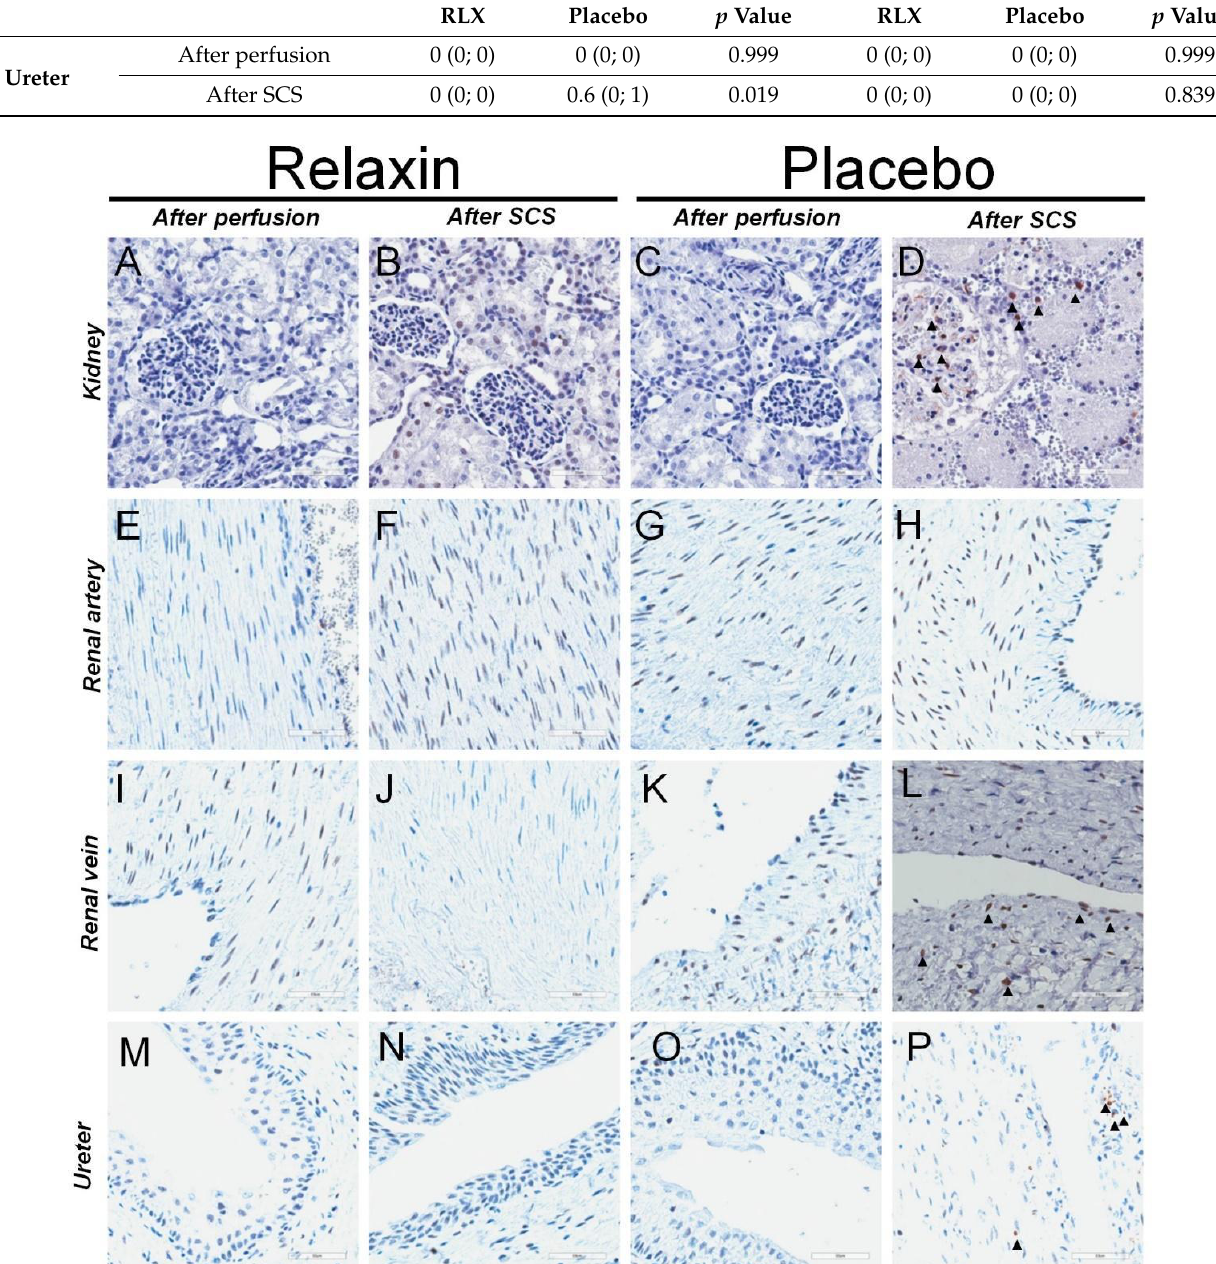
Figure 4. Pictures depicting typical staining for activated Caspase 3 in kidney, renal artery, renal vein, and ureter tissues after perfusion and static cold storage in RLX or control. Representative staining for kidney tissue at 100× magnification for Caspase 3 after perfusion ( A ) and static cold storage ( B ) with RLX and after perfusion ( C ) and static cold storage ( D ) with Custodiol ® . Caspase 3 positive cells were more common after SCS in a Placebo group. Representative staining for renal artery tissue against Caspase 3 after perfusion ( E ) and static cold storage ( F ) with Custodiol ® supplemented with Relaxin or after perfusion ( G ) and static cold storage ( H ) with Placebo. Representative staining for renal vein tissue against Caspase 3 after perfusion ( I ) and static cold storage ( J ) with Relaxin or after perfusion ( K ) and static cold storage ( L ) with Placebo. Caspase 3 positive cells were more common after SCS in a Placebo group. Representative staining for ureter tissue against Caspase 3 after perfusion ( M ) and static cold storage ( N ) with Relaxin or after perfusion ( O ) and static cold storage ( P ) with Placebo. Caspase 3 positive cells were more common after SCS in a Placebo group. All scale bars represent 50 um.